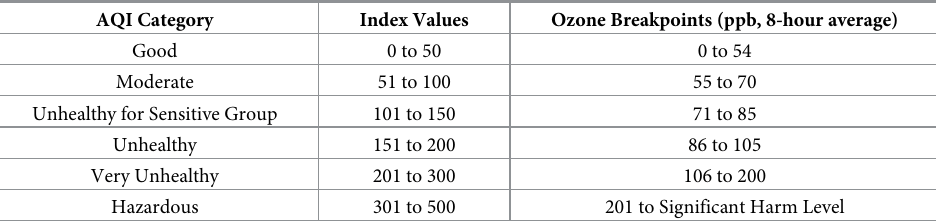
Table 1. The category of the air quality index and the ozone concentration breakpoints